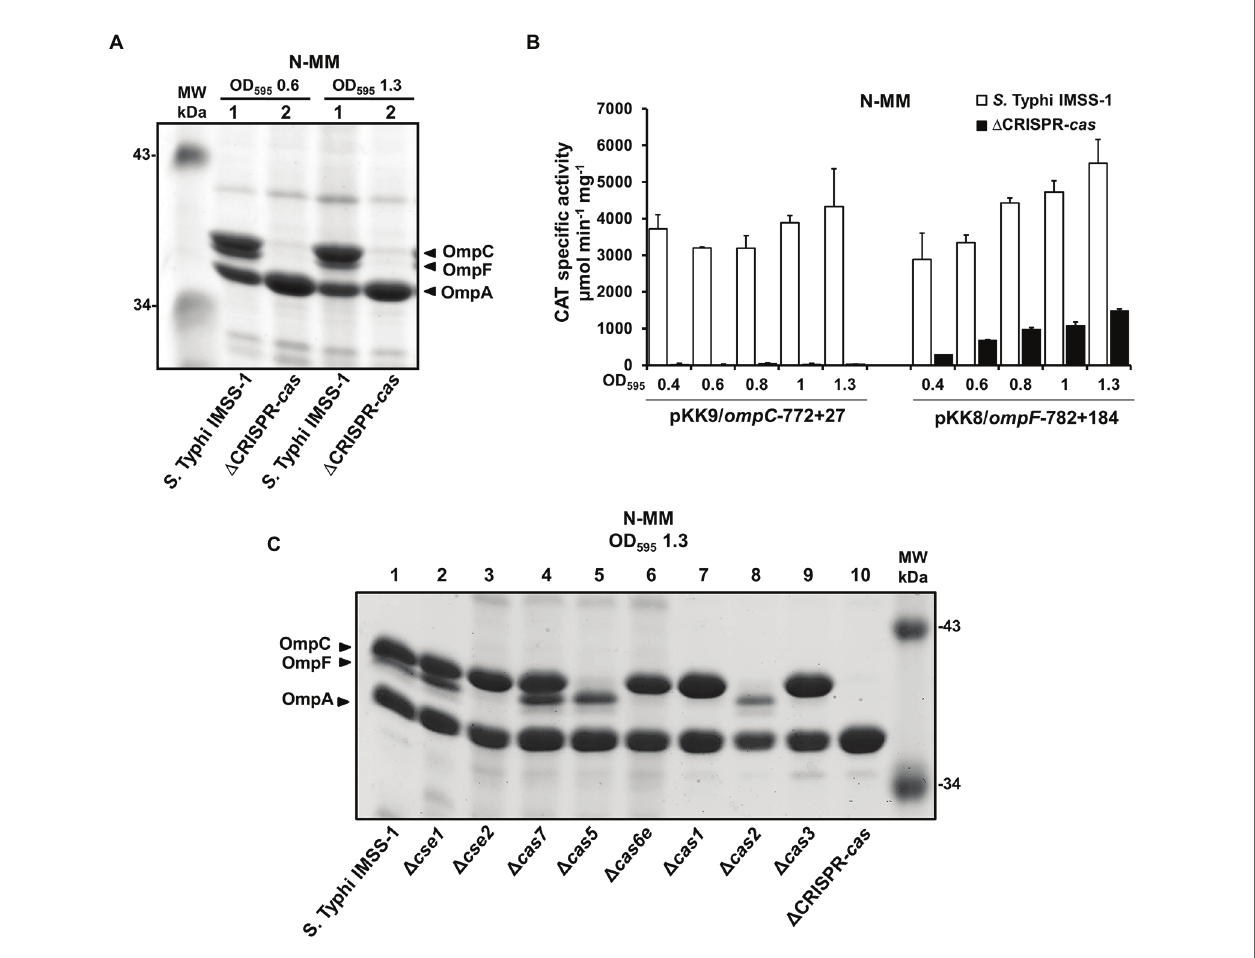
FIGURE 2 | CRISPR-Cas is fundamental for the synthesis of the major outer membrane proteins OmpF and OmpC in Salmonella Typhi. (A) Electrophoretic pattern of Coomassie brilliant blue-stained outer membrane protein preparations, separated by 0.1% SDS-15% PAGE. The bacterial strains Salmonella Typhi IMSS-1 wild type (lane 1) and Salmonella Typhi Δ CRISPR- cas ( Δ CRISPR- cas , lane 2) were grown in N-MM to an OD 595 of 0.6 and 1.3. The major OMPs, OmpC, OmpF, and OmpA are indicated with a black triangle. (B) Transcriptional profiles of Salmonella Typhi IMSS-1 and Salmonella Typhi Δ CRISPR- cas harboring plasmid pKK9/ ompC -772 + 27 or pKK8/ ompF -782 + 184 in N-MM. CAT-specific activities were measured at an OD 595 of 0.4, 0.6, 0.8, 1.0, and 1.3. The values are the means ± standard deviations for three independent experiments performed in duplicate. (C) Electrophoretic pattern of Coomassie brilliant blue-stained outer membrane protein preparations, separated by 0.1% SDS-15% PAGE from Salmonella Typhi IMSS-1 wild type (lane 1), Δ cse1 (lane 2), Δ cse2 (lane 3), Δ cas7 (lane 4), Δ cas5 (lane 5), Δ cas6e (lane 6), Δ cas1 (lane 7), Δ cas2 (lane 8), Δ cas3 (lane 9), and Salmonella Typhi Δ CRISPR- cas ( Δ CRISPR- cas , lane 10) strains, grown in N-MM at